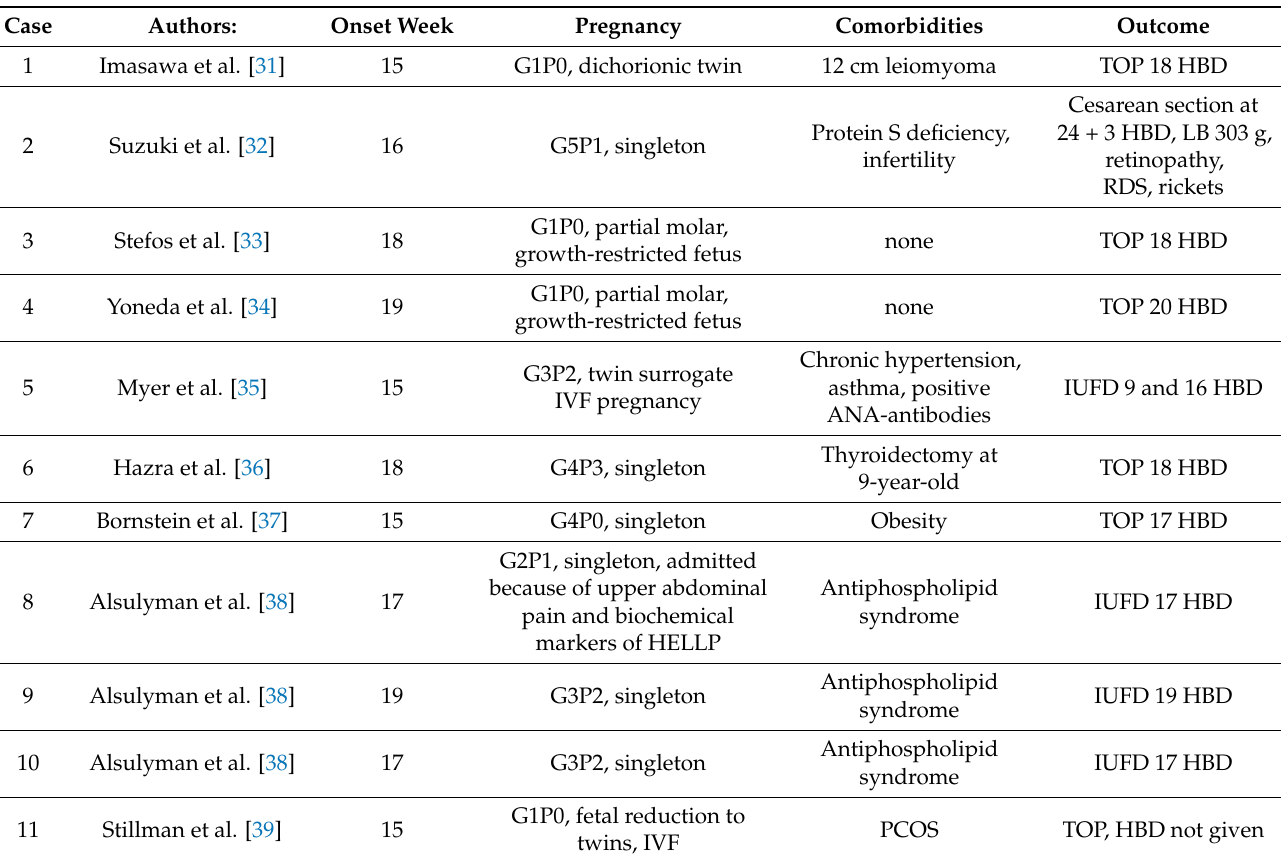
Figure 3. Pregnancy outcome—number of cases (%); maternal comorbidities—number of cases. * Selective termination and live birth of other twin/triplets. APS—antiphospholipid syndrome, PPH—pre-pregnancy hypertension. Table 2. Reported angiogenesis markers. Soluble FMS-like tyrosine kinase-1 (sFlt-1)/Placental Table 3. Presentation and summary of included cases. Papers (n = 30) and cases (n = 34) were growth factor (PLGF).